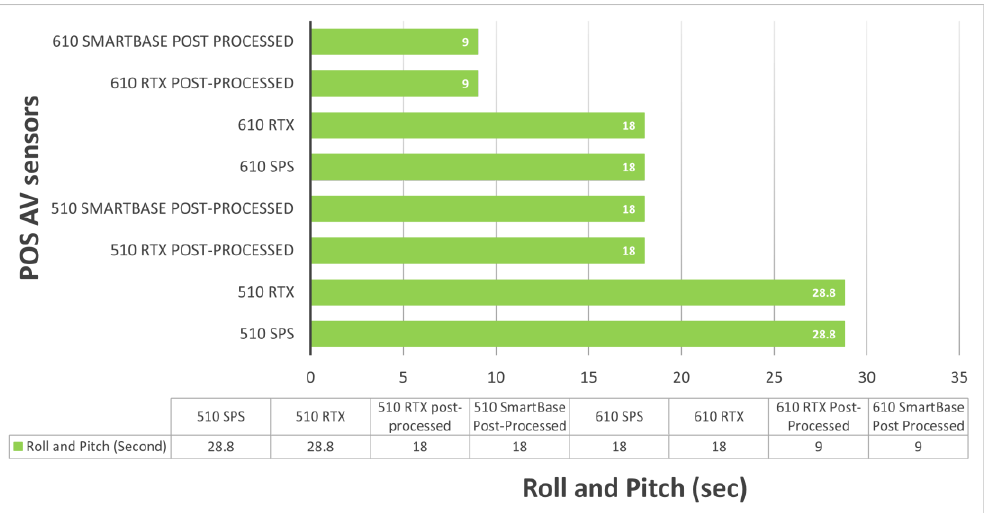
Figure 5. Accuracy of roll and pitch parameters in different POS AV INS